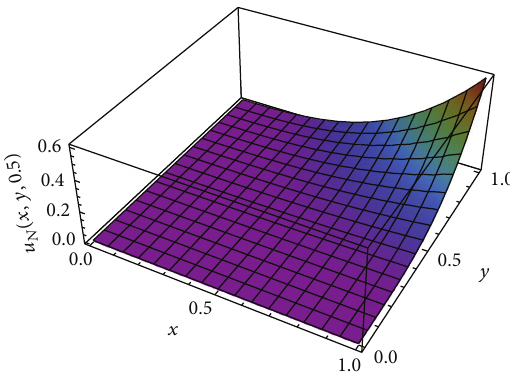
Figure 1: Space graph of numerical solution of problem (40).